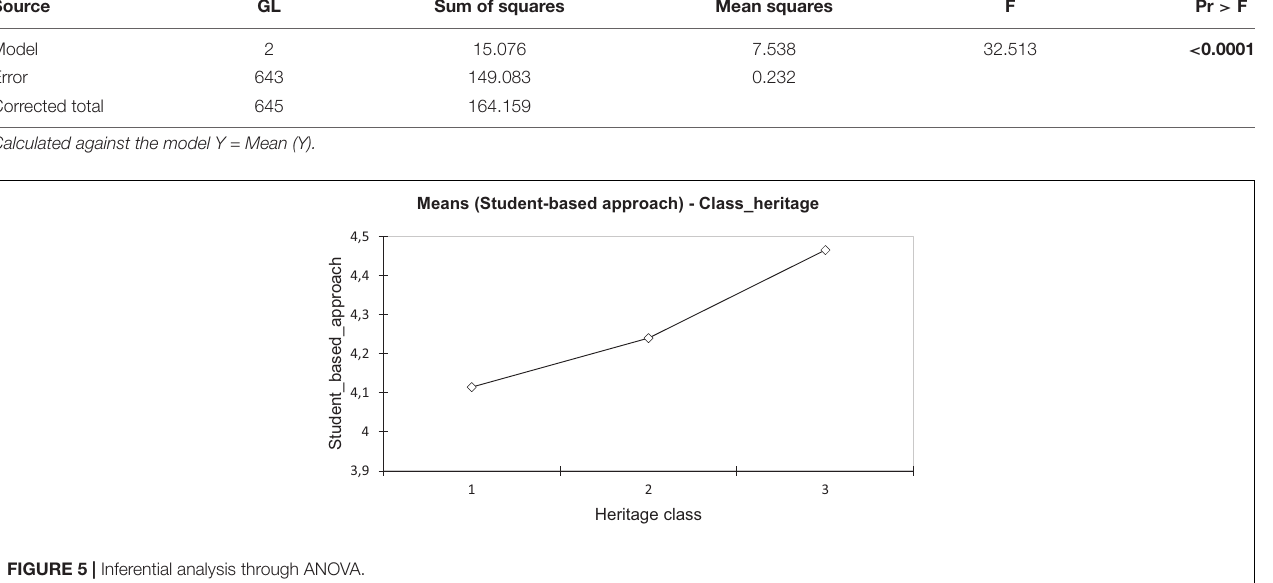
TABLE 7 | Analysis of variance (ANOVA) between the student-based approach and the classes on the use of heritage. Source GL Sum of squares Mean squares